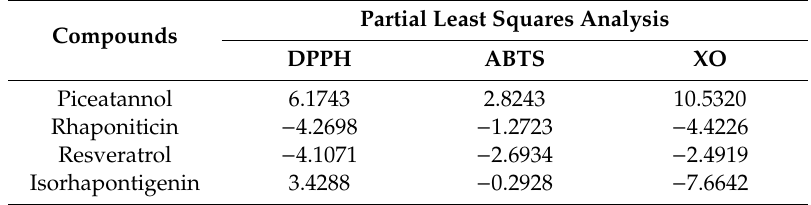
Table 4. The parameters of partial least squares analysis of four active compounds and